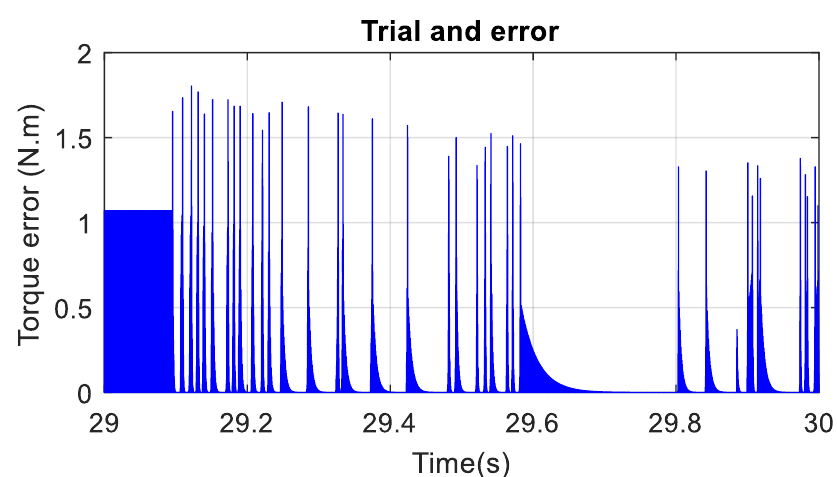
Figure 20. BEV absolute torque error based on trial and error.